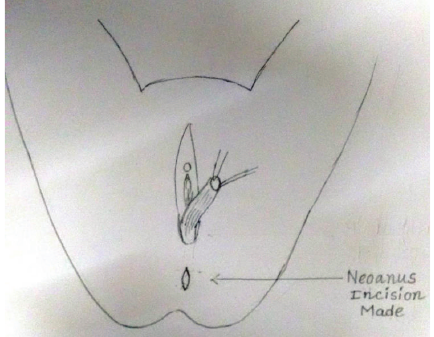
Figure 6: Anorectum transposed within sphincteric complex.